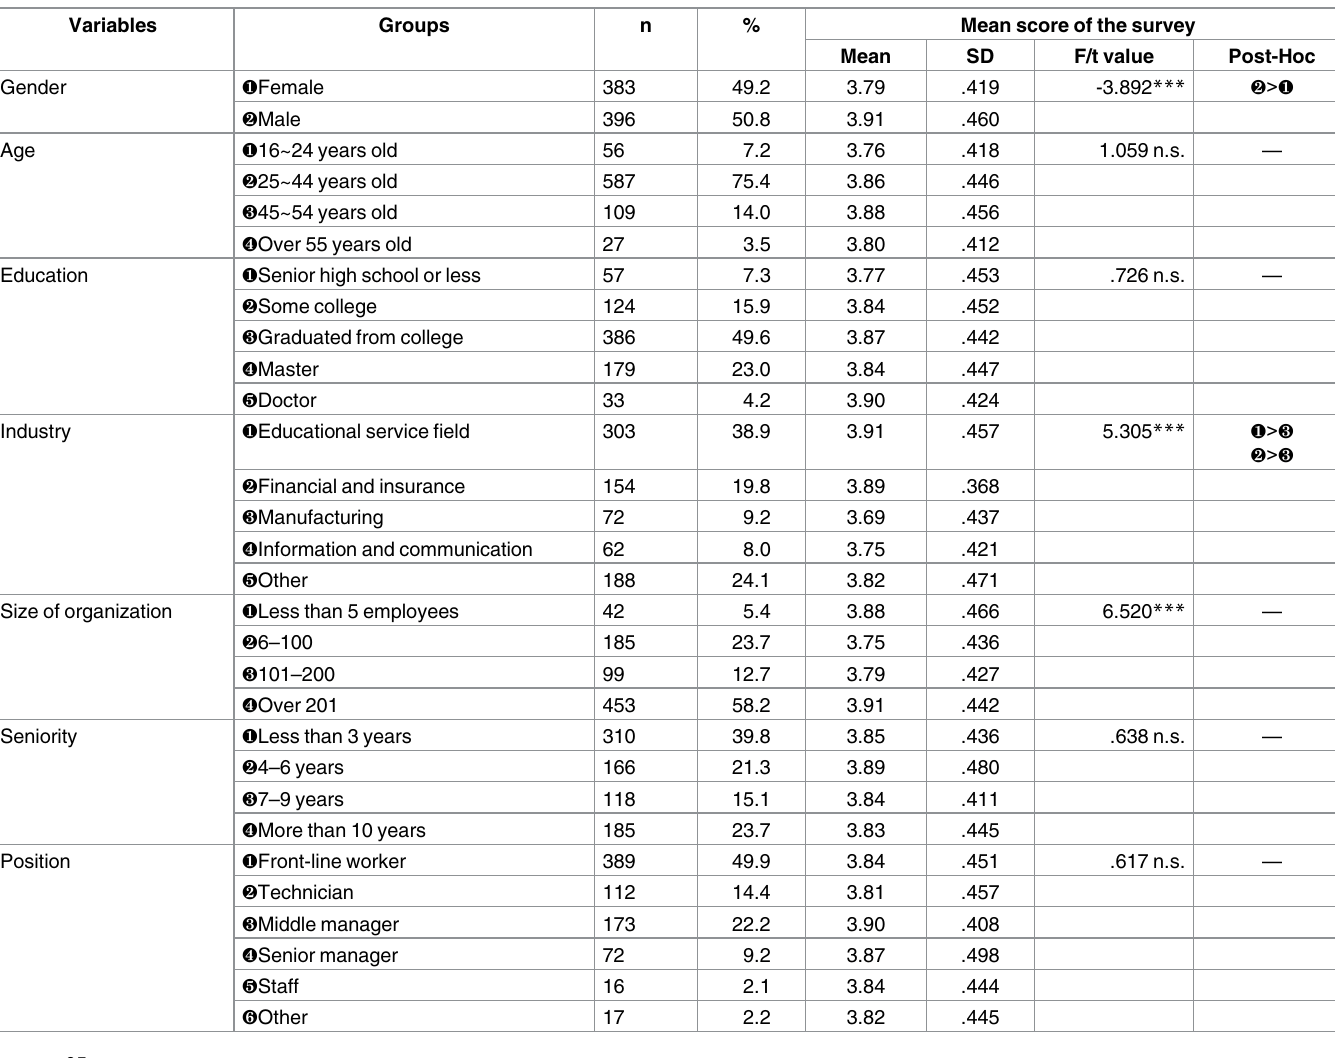
Table 3. Profile of participants (N = 779).